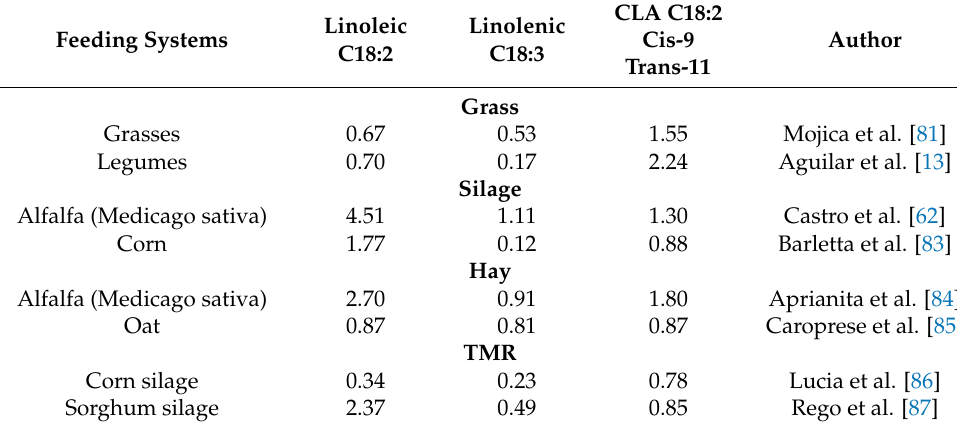
Table 5. Effects of different feeding systems (grass, silage, hay, TMR) on linoleic, α -linolenic, and CLA (g/100 g of fat) contents in cow’s